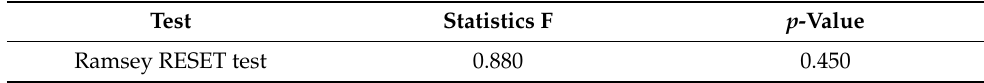
Table A13. The results of the specification test of the fourth